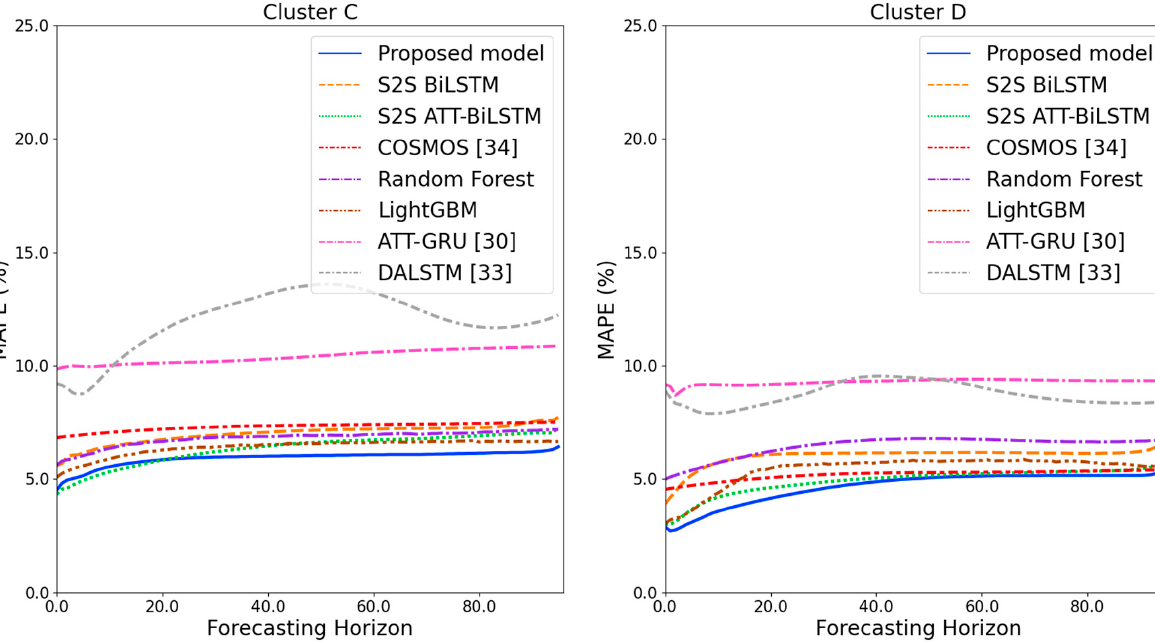
Figure 12. MAPE results of clusters C and D over the entire forecasting horizon (%).